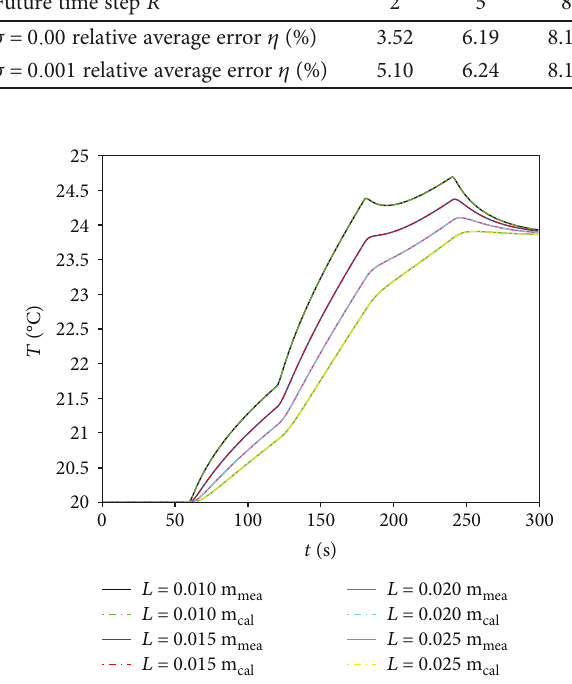
Figure 7: The history of measured and calculated temperatures for di ff erent measuring point positions when σ = 0 00 and R = 2 .